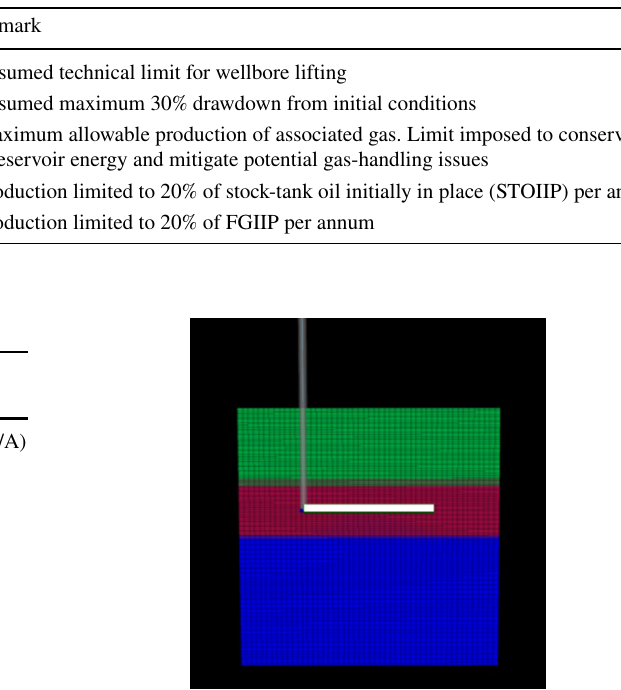
Table 2 Some well controls used in the simulations